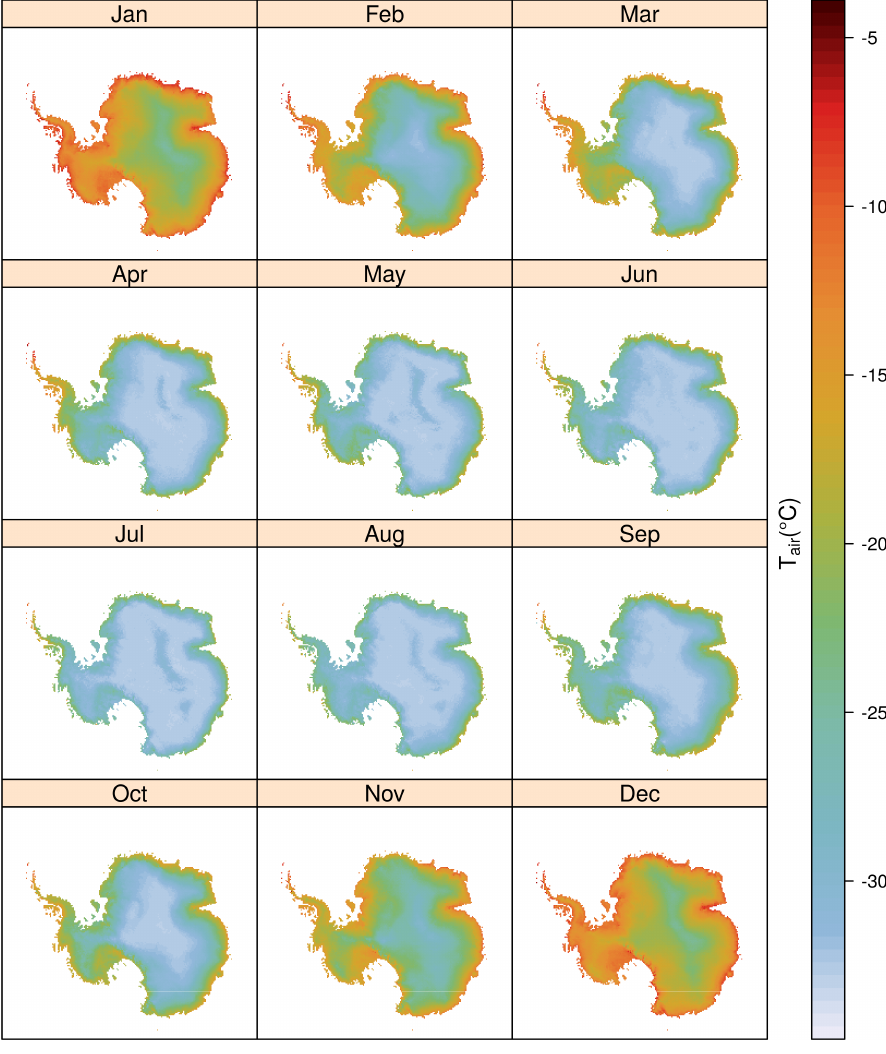
Figure 9. Performance of the T air product on different aggregation levels.